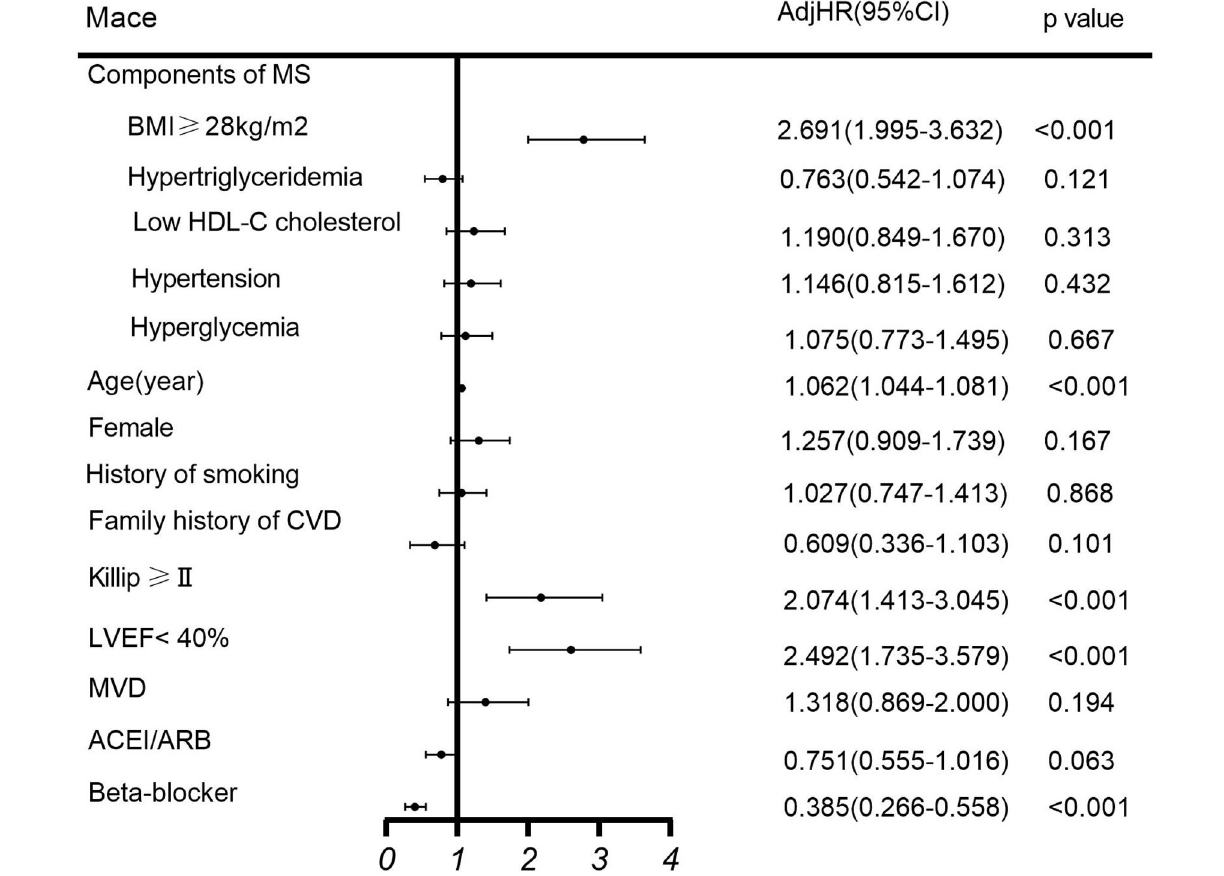
FIGURE 2 | Multivariate COX regression analysis of MACE. ACEI, angiotensin-converting enzyme inhibitor; ARB, angiotensin receptor blocker; BMI, body mass index; CI, confidence interval; CVD, cardiovascular disease; HDL-C, high-density lipoprotein cholesterol; HR, hazard ratio; LVEF, left ventricular ejection fraction; MACE, major adverse cardiovascular events; MS, metabolic syndrome; MVD, multivessel